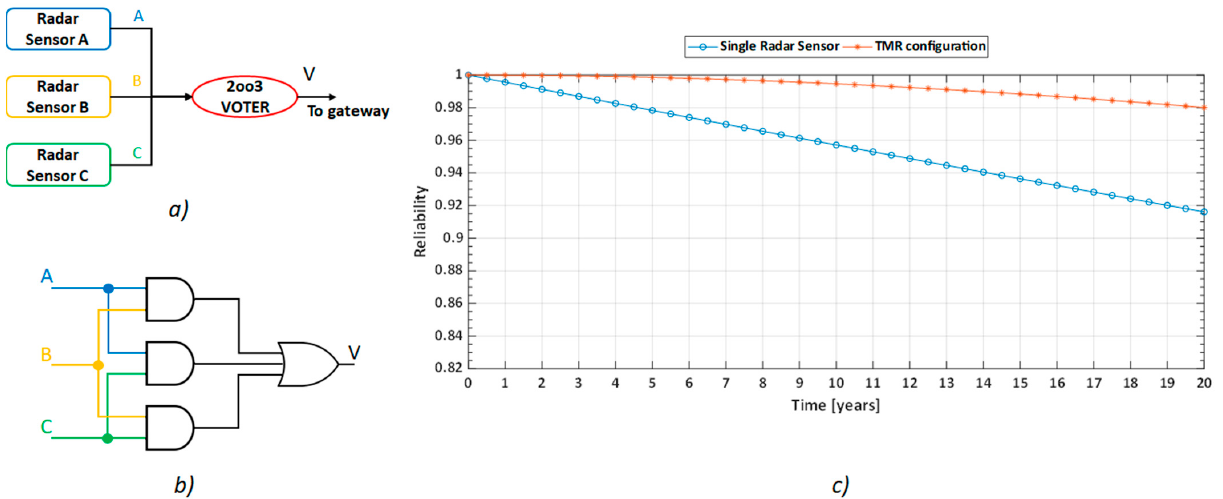
Figure 5. Proposed solution to achieve hardware fault tolerance for the radar sensor in each room: ( a ) RBD of the proposed TMR architecture; ( b ) logical scheme implementation of the majority-voting system in case of digital output of the sensors; ( c ) comparison between the reliability trends of a single radar sensor (blue curve) and of a fault tolerant architecture comprising 3 radar sensors (red curve).